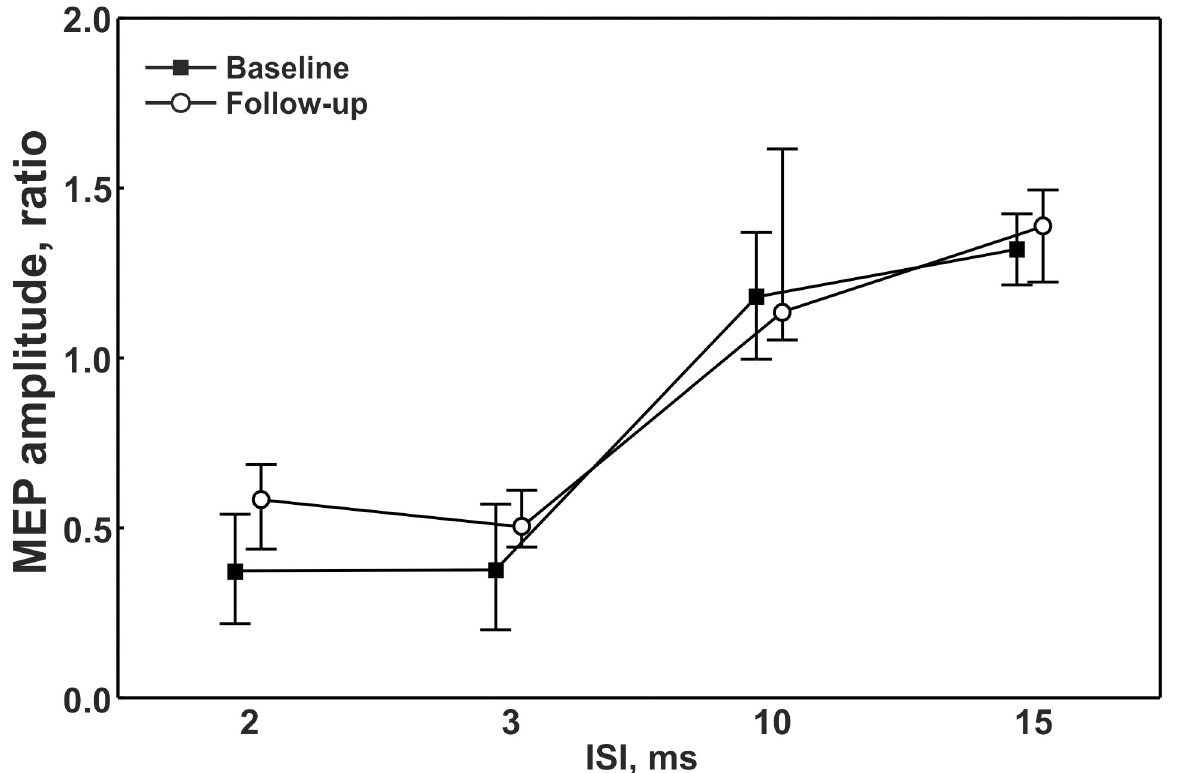
Fig 1. Intracortical excitability at different interstimuls intervals at baseline and follow-up. ISI = interstimuls interval; MEP = Motor Evoked Potential.